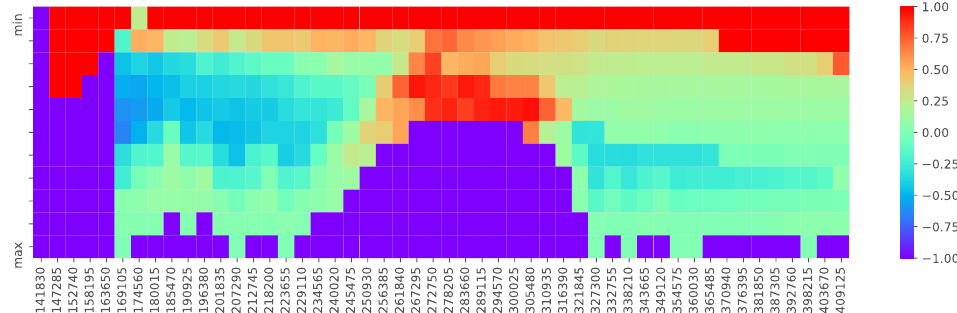
Figure 7. The Allocation Results of